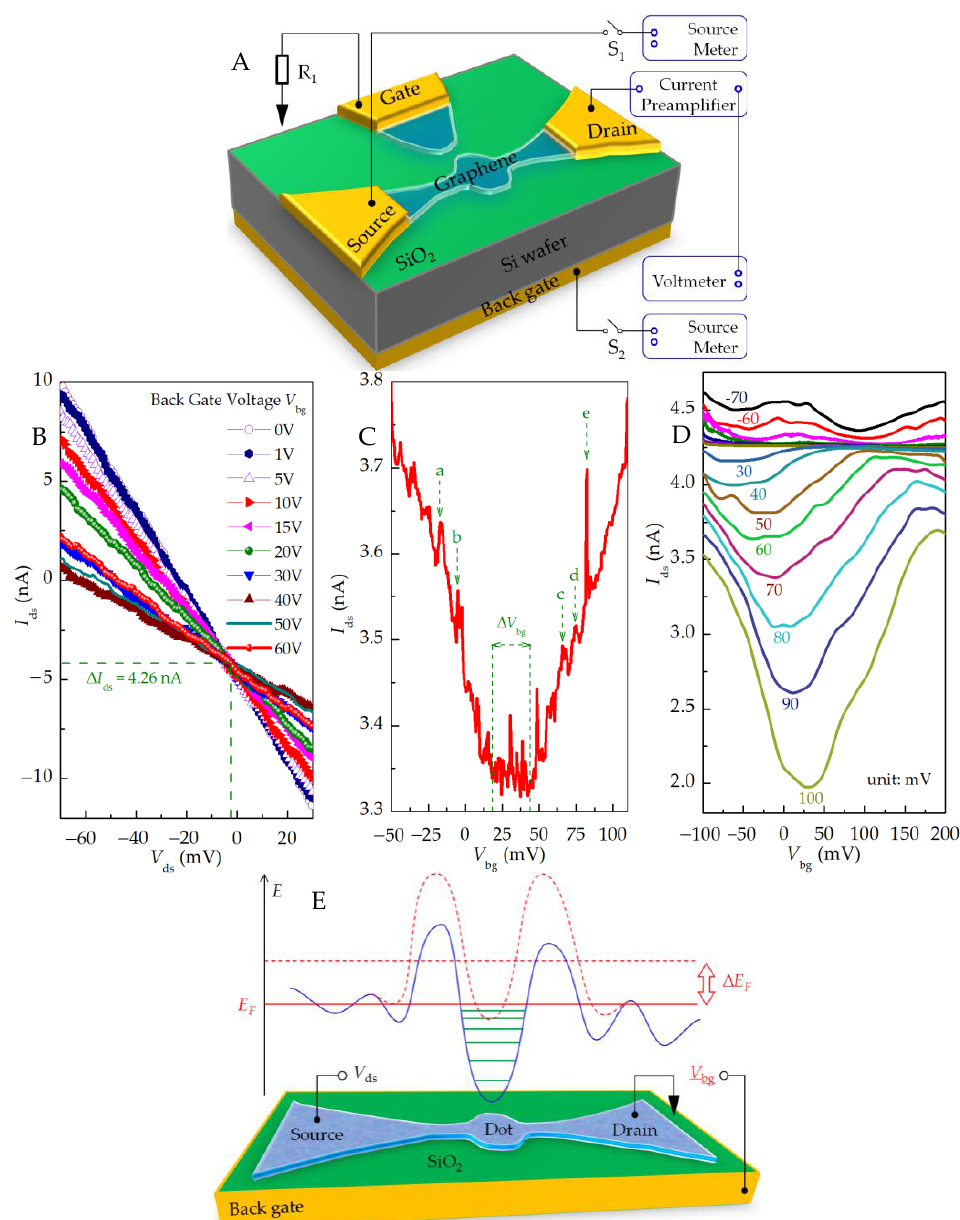
Figure 4. ( A ) Circuit diagram of back gate regulation test. The source–drain current I ds is measured with a current preamplifier (DL Instrument 1211; amplification factor, 10 −5 A/V; rise time, 300 ms) and a digital multimeter. ( B ) Source–drain I–V characteristic curves under different back gate voltages intersect at V ds ≈ − 2 mV, and the source–drain current has a bias current of ~4.26 nA, which is introduced by the preamplifier test circuit. Back gate regulation characteristics under ( C ) a certain source–drain bias and ( D ) different source–drain bias voltages. ( E ) Diagram of potential energy along the graphene source–drain channel. The blue solid line represents the potential energy curve of graphene source and drain channel. The movement and change of different positions under the control of the back grid are different, and may finally have the shape of red dotted line.